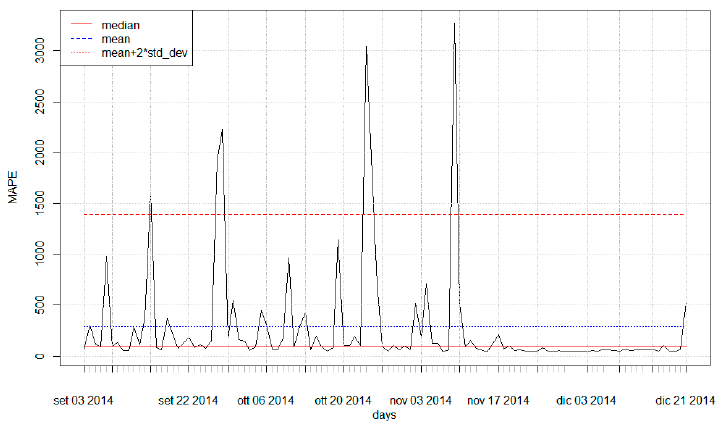
Figure 13. MAPE over the observation period for the non-residential case (Case 2).